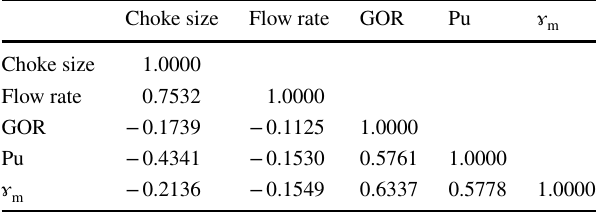
Fig. 1 Total flow rate versus choke size of the raw data Table 2 Correlation between the input and the output parameters